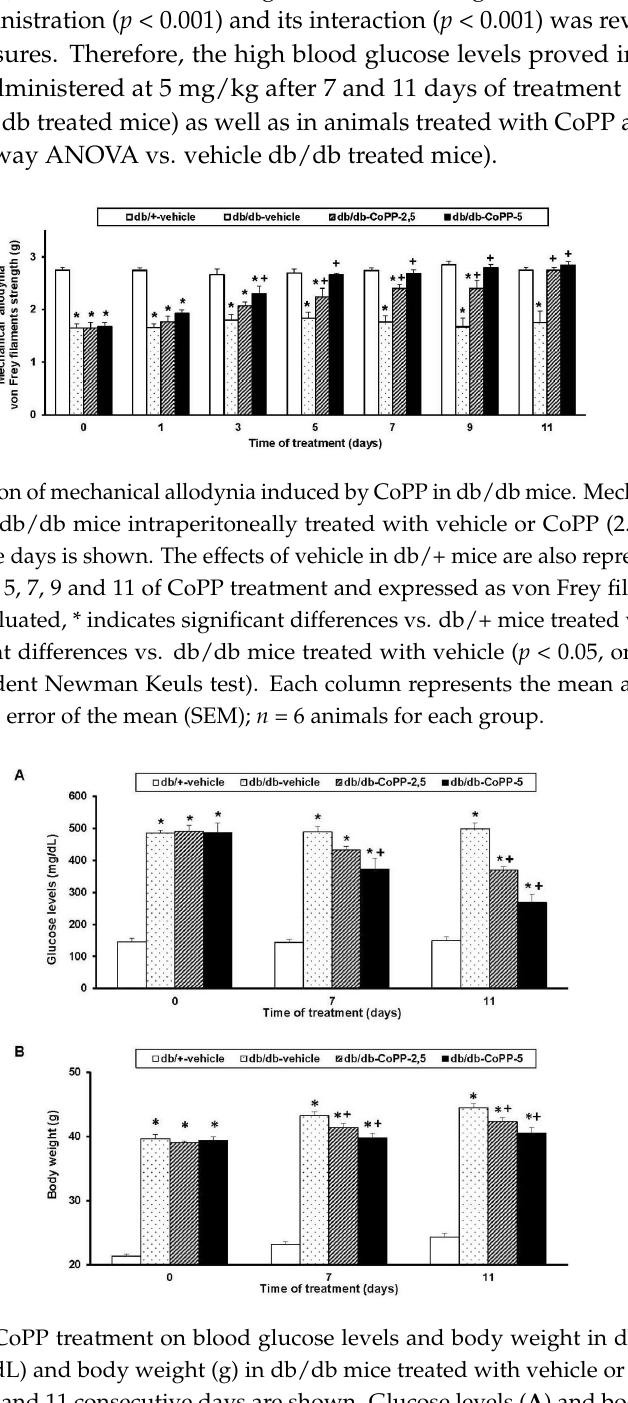
0.001), time of administration ( p < 0.001) and its interaction ( p < 0.001) was revealed by a two way